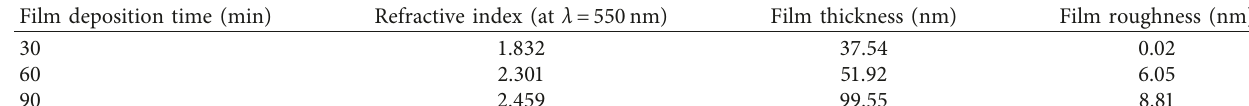
2 thin films for different deposition times. 2 thin films.